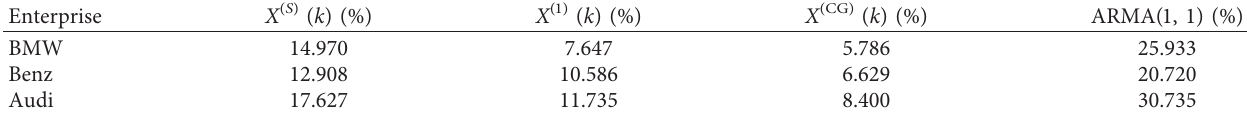
Table 4: Grey transformation error (MAPE).